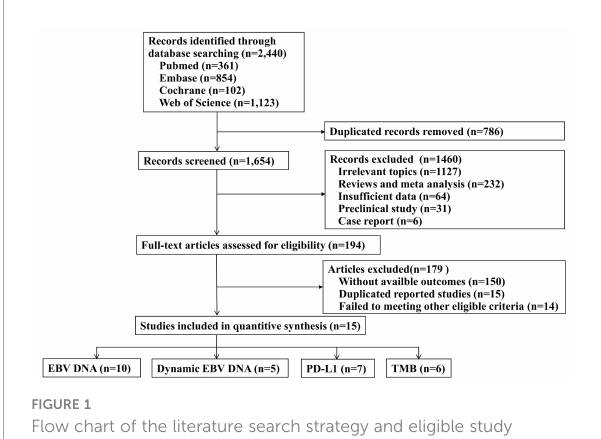
FIGURE 1 Flow chart of the literature search strategy and eligible